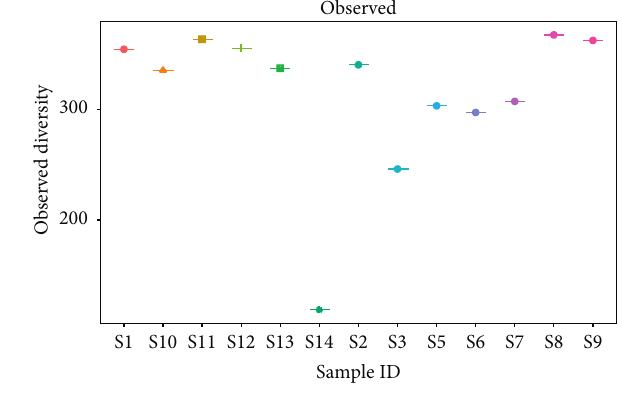
Figure 9: Results of alpha diversity analysis in ranacapa